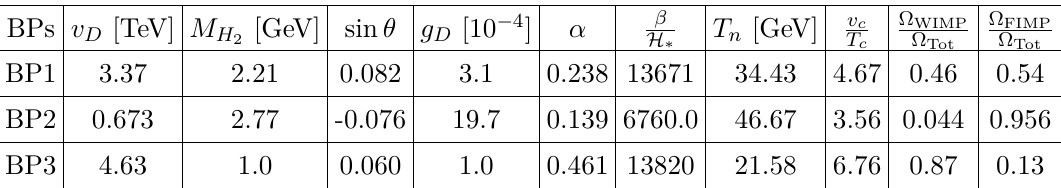
Table 2 . Three BPs. The first four columns represent the input model parameters, the fifth, sixth, and the seventh columns are GW-related quantities, the eighth column shows the strength of the FOPT. The last two columns denote the WIMP and FIMP contributions to the total DM relic density Ω 2 = 0 . 12 ; for the first BP, both the WIMP and FIMP equally contribute to the total Tot h DM relic density, while the second (third) BP is mostly composed of FIMP (WIMP) DM. In all the three cases, the LFV bounds are satisfied, and the neutrino masses can successfully be